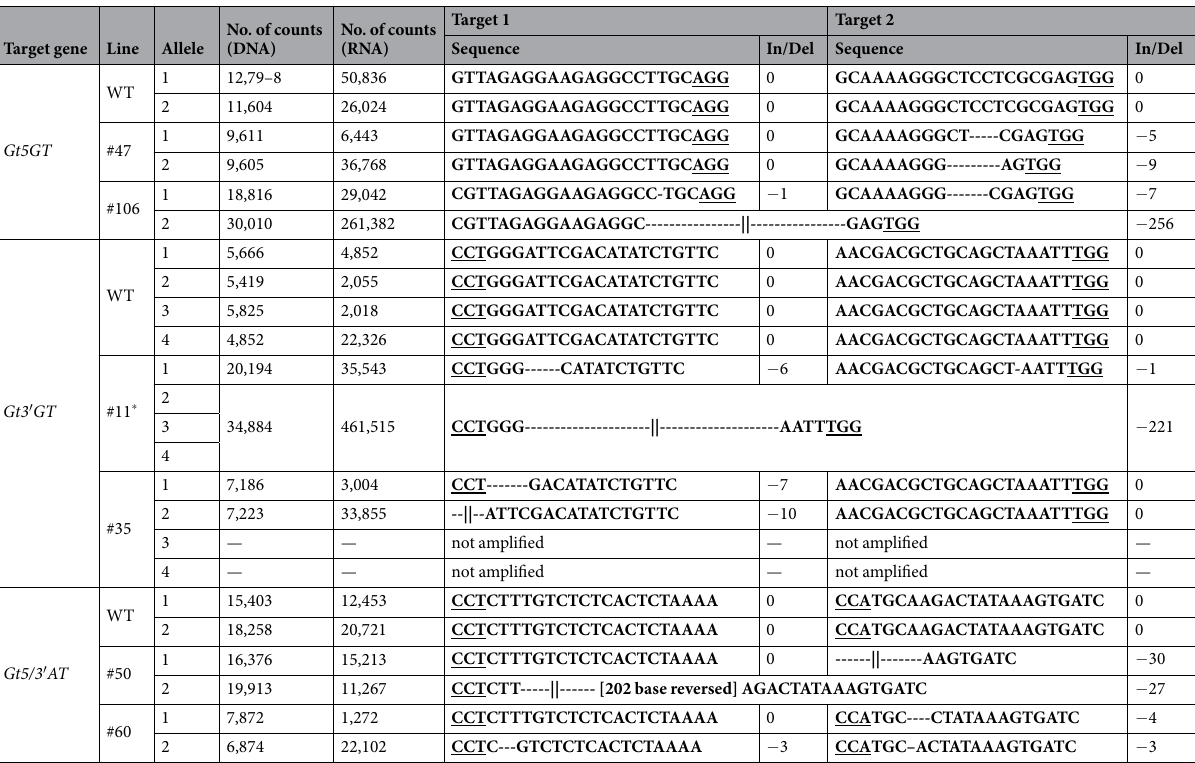
Table 1. NGS analysis of PCR amplicons of DNA and RNA of genome-edited lines. Double underlines show PAM sequences. * Allele 2, 3 and 4 are indistinguishable from each other due to large